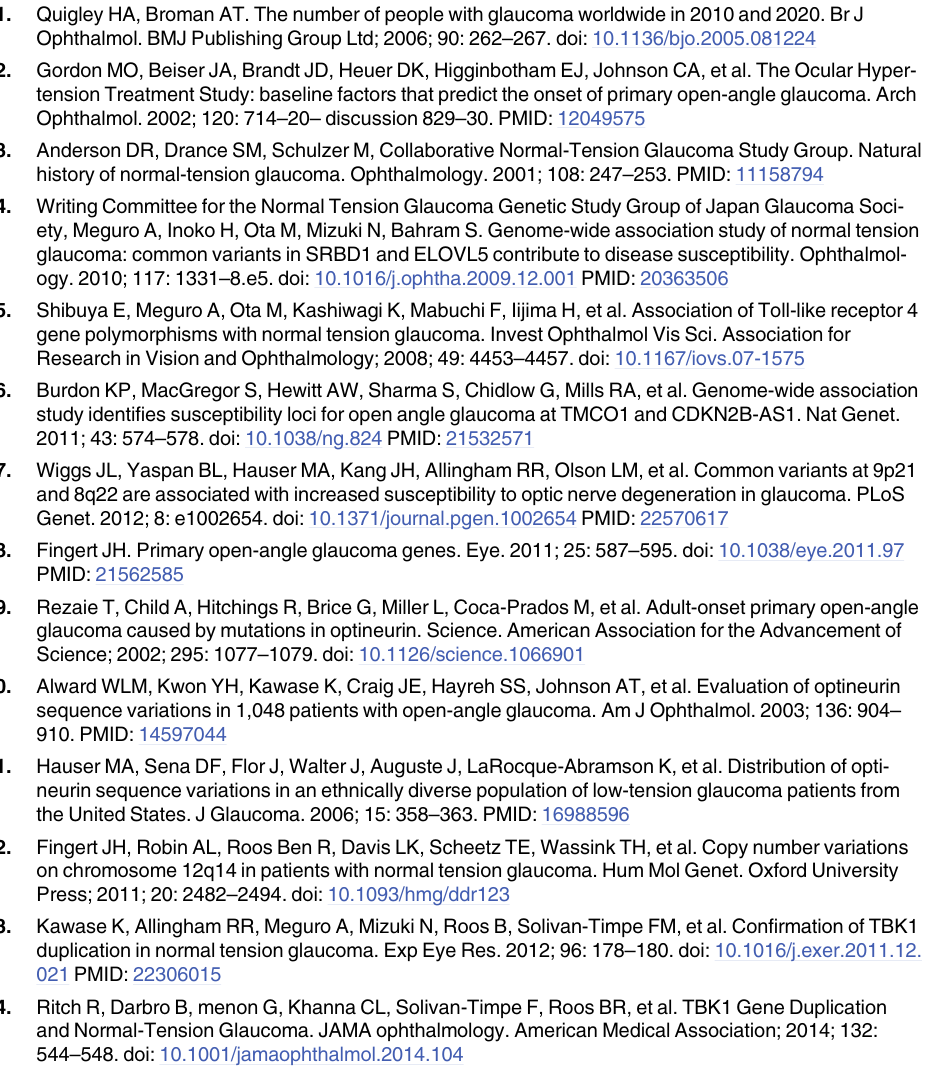
S1 Table. Variations detected in the SQSTM1 gene in control subjects by exome analysis. Column 1 (Variants detected in the SQSTM1 gene by the exome study) lists detected variants annotated relative to the hg19 reference genome. Column 2 (Variant location relative to SQSTM1 coding sequence) lists variants annotated relative to the transcript in HGVS standard nomenclature